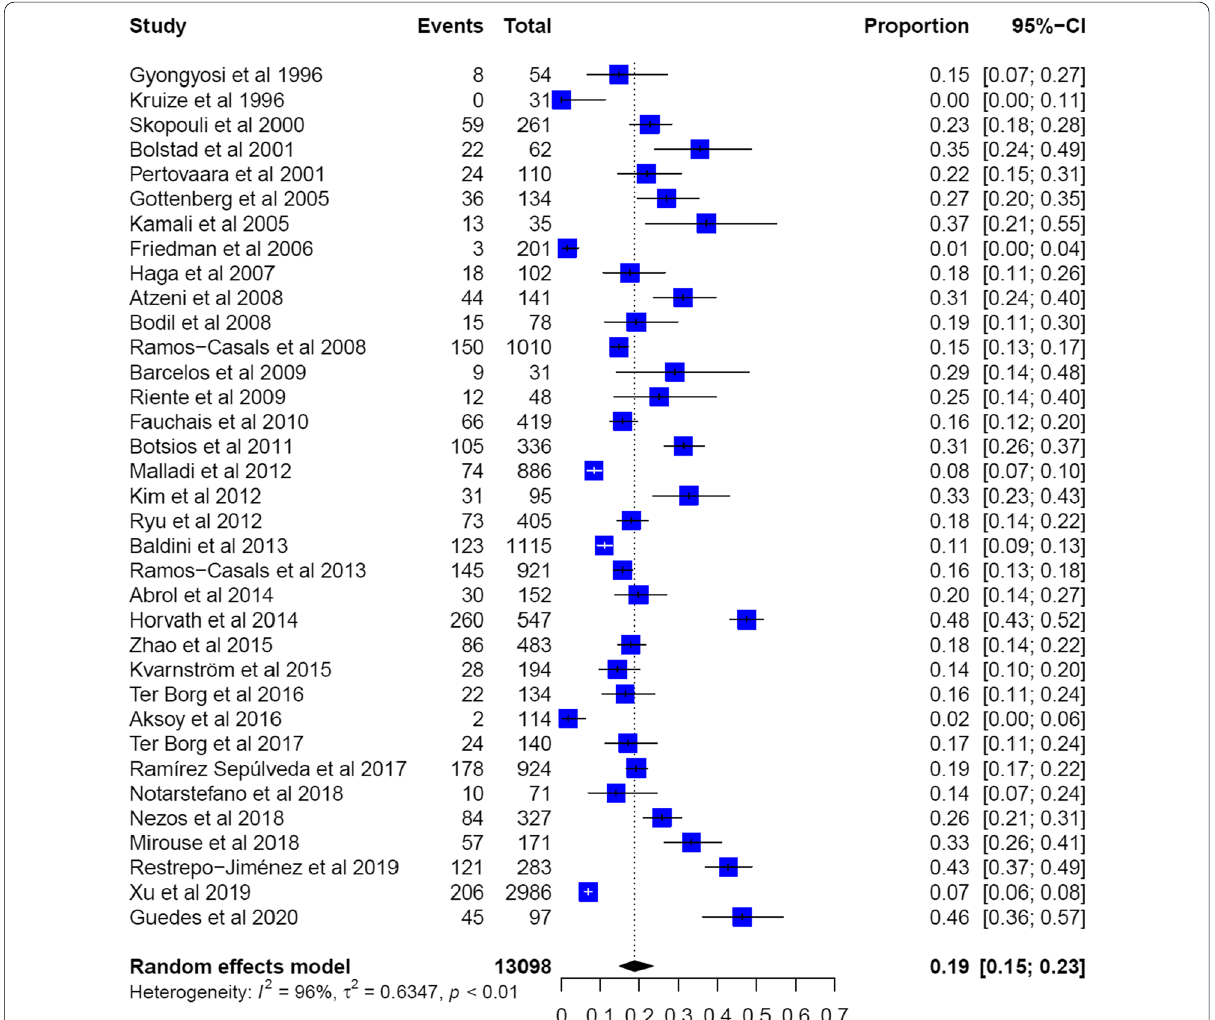
Fig. 3 Meta‑analysis of the Arthritis in patients with Sjogren’s